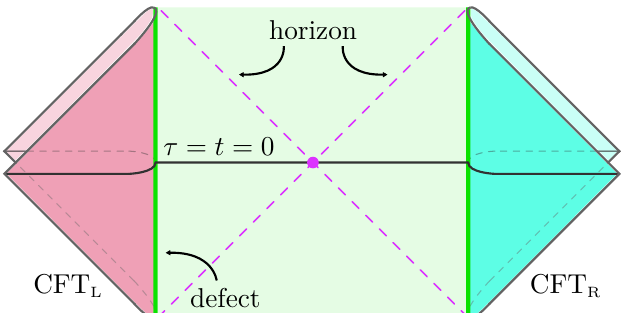
Figure 6. Our eternal black hole coupled to the CFT bath, as seen from the effective brane perspective . Each point in the Penrose diagram represents a hyperbolic space H d − 2 . For d = 2 this is simply a point.